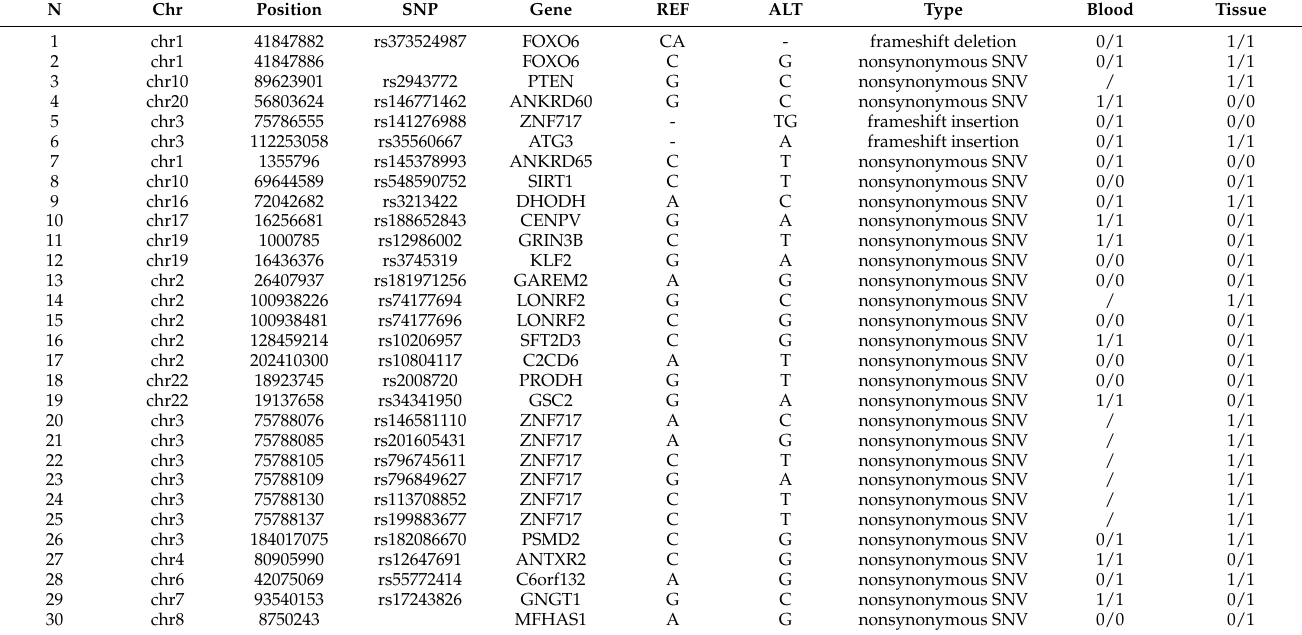
Table 3. Summary of selected